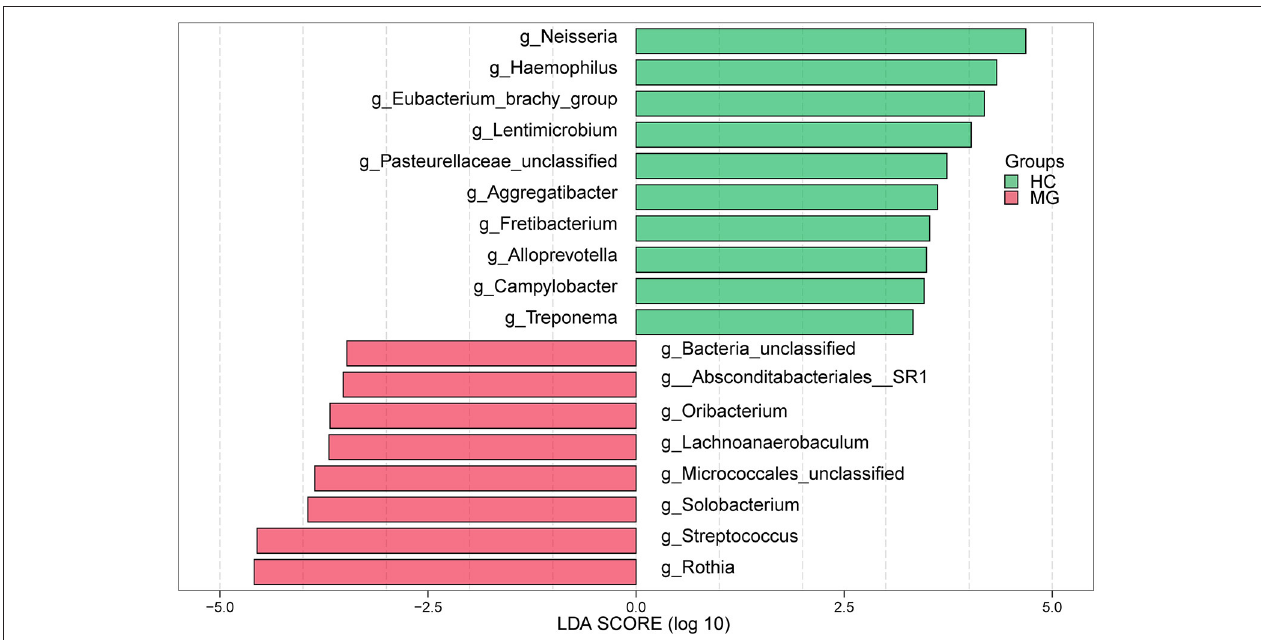
FIGURE 3 | LEfSe analysis of microbial profiles between in MG ( N = 20) and HC ( N = 20) groups at the genus level. The histogram of LDA scores calculated for select taxa showed significant differences in microbe type and abundance between MG (green) and HC (red). LDA scores on a log 10 scale are shown at the bottom. The significance of a microbial marker increased with LDA